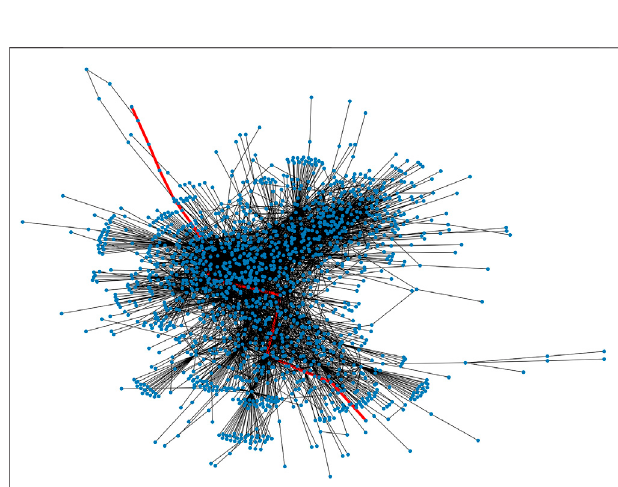
FIGURE 8 | Day 200 Visualization of networks and their tandem nodes. As the network grew in size, the same sequence of day 100 strung together more nodes and formed aring in thenetwork (top left part ofthe fi gure), which has been having a massive impact on the network ’ s diameter.